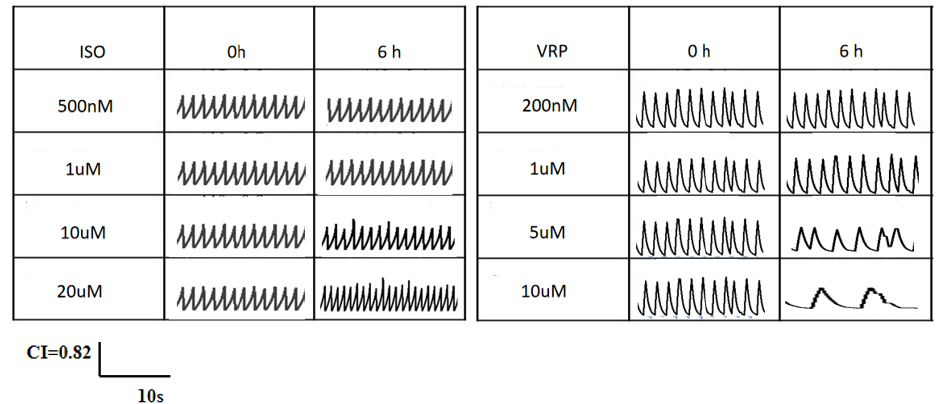
Figure 8. Beat signal changes in the cardiomyocyte EIS sensors after treatment with different concentrations of isoproterenol (ISO) and verapamil (VRP), with a time lapse of 10 s for the signal fragments and a maximum CI of 0.82.